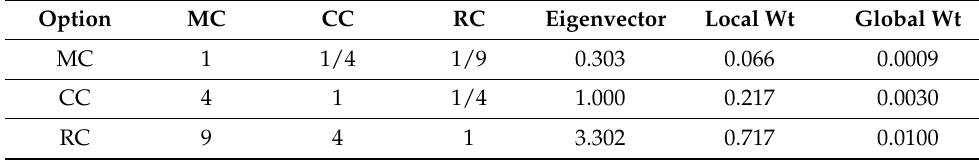
Table A15. Comparison of alternatives matrix for subcriterion